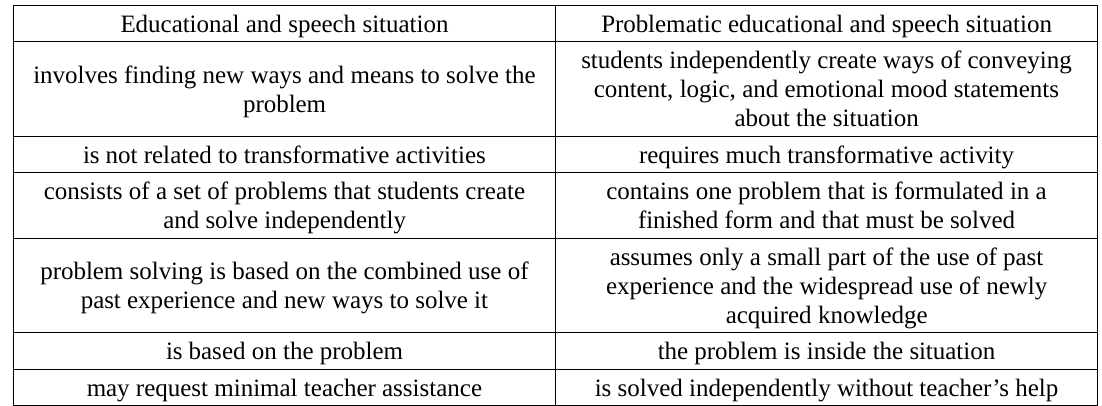
Table 1 - Distinctive Characteristics of Educational and Speech Situation and Problematic Teaching and Speech Situation